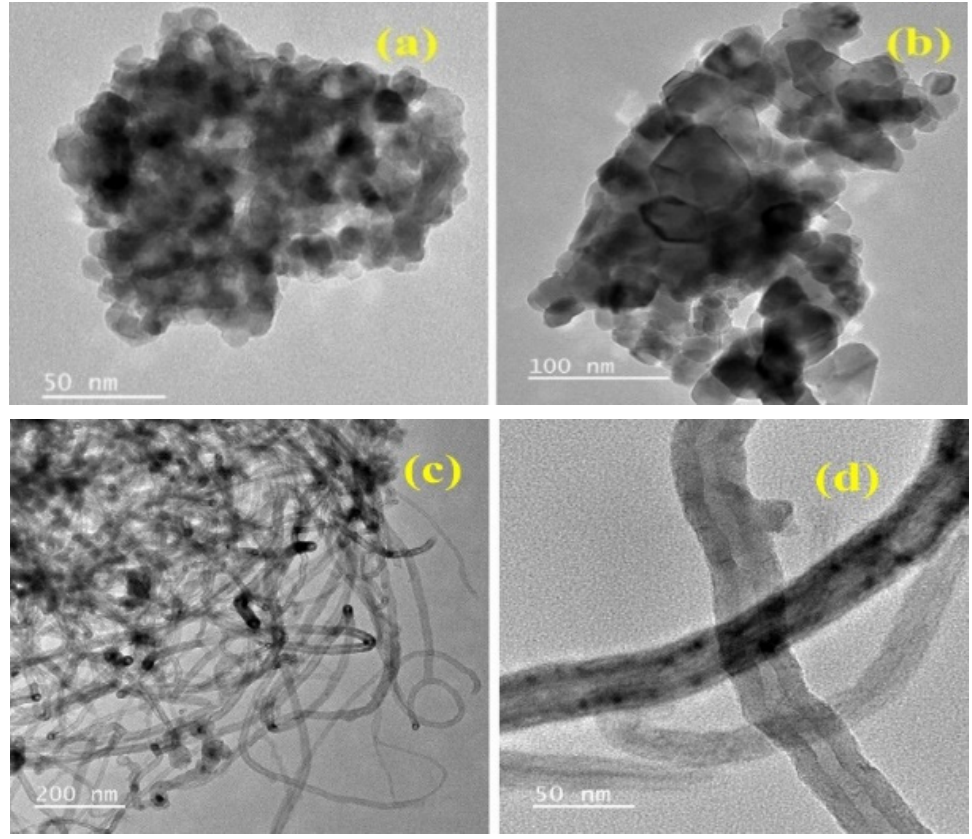
Figure 4. TEM of STO ( a ), 5% CuO/STO ( b ), and 5% CuO/STO/MWCNTs ( c , d ).